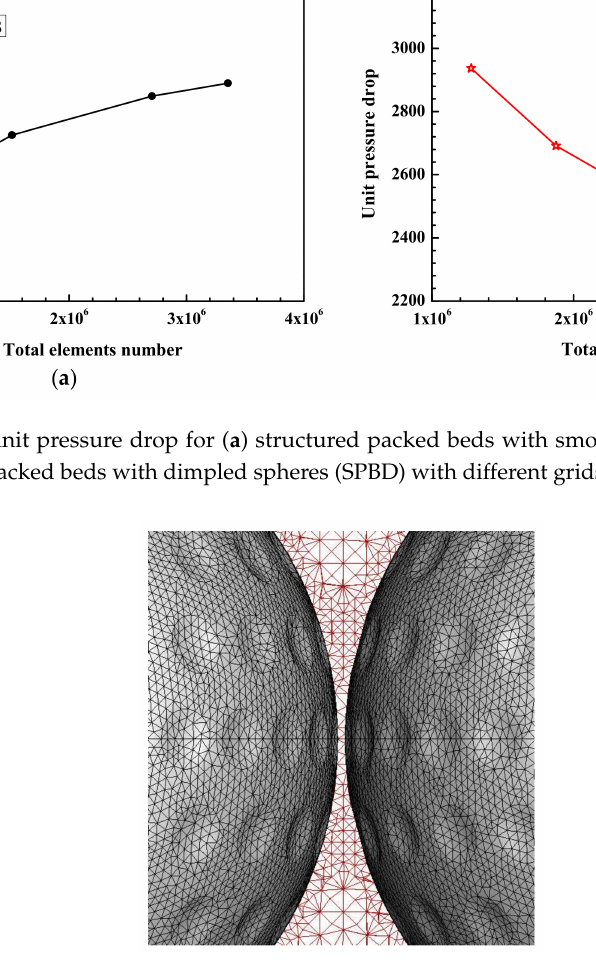
Figure 5. The mesh near the contact point of packed bed with dimple